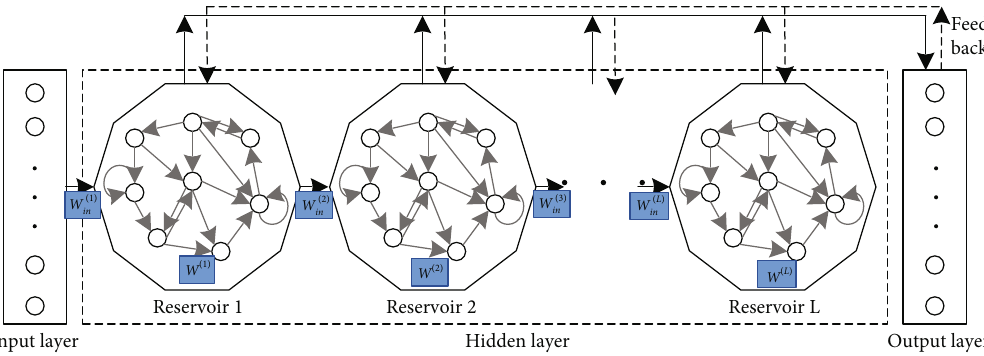
Figure 3: Deep echo state network